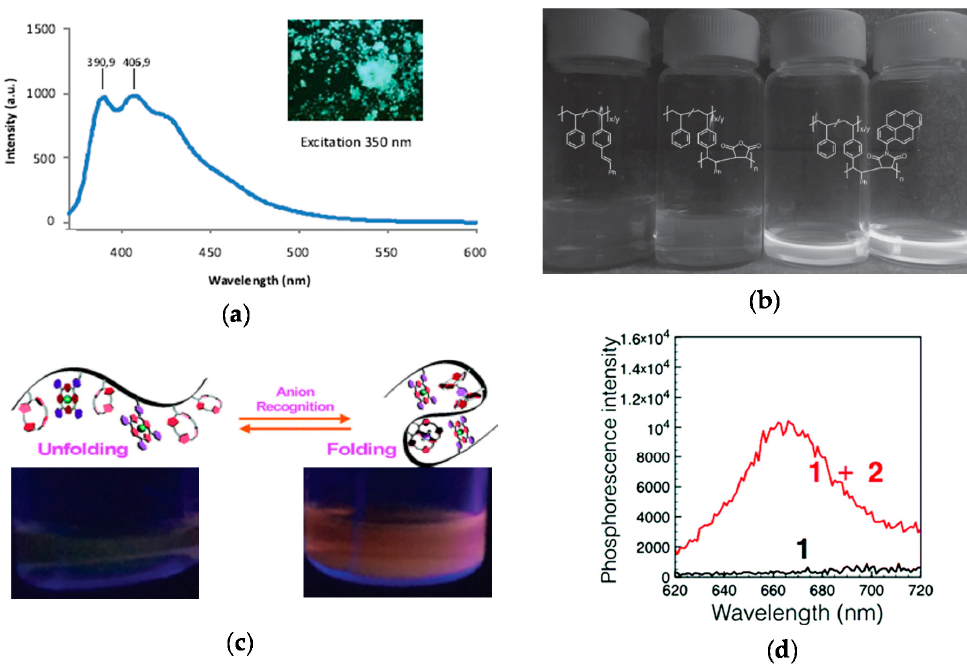
Figure 8. Synthesis of fluorescent SCNPs upon intramolecular cross-linking via formation of fluorophore triazole-benzene-triazole units (inset) and photophysical characterization of the resulting fluorescent SCNP ( a ), fluorescent SCNPs prepared from precursor polymers containing pendant stilbene units pendant stilbene units through intrachain alternating copolymerization with N -(1-pyrene)maleimide ( b ), and phosphorescent SCNPs synthesized by means of anion recognition ( c ); “switch on” of phosphorescence upon anion binding is illustrated in ( d ) (red curve) (reprinted with